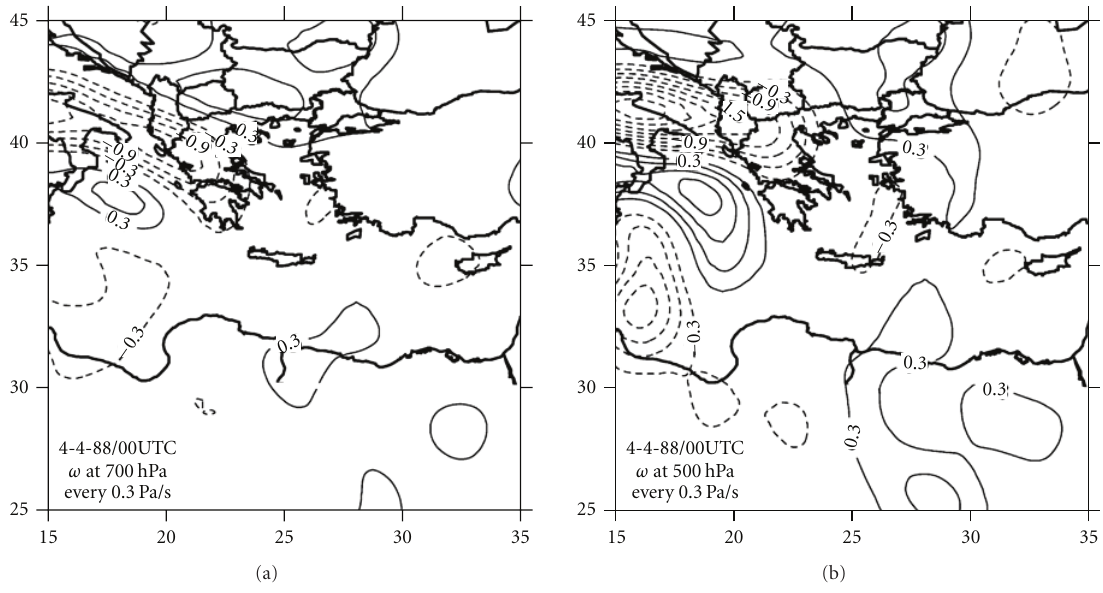
Figure 16: As Figure 2, but for 00:00 UTC on 4 April 1988, (a) 700 hpa and (b)